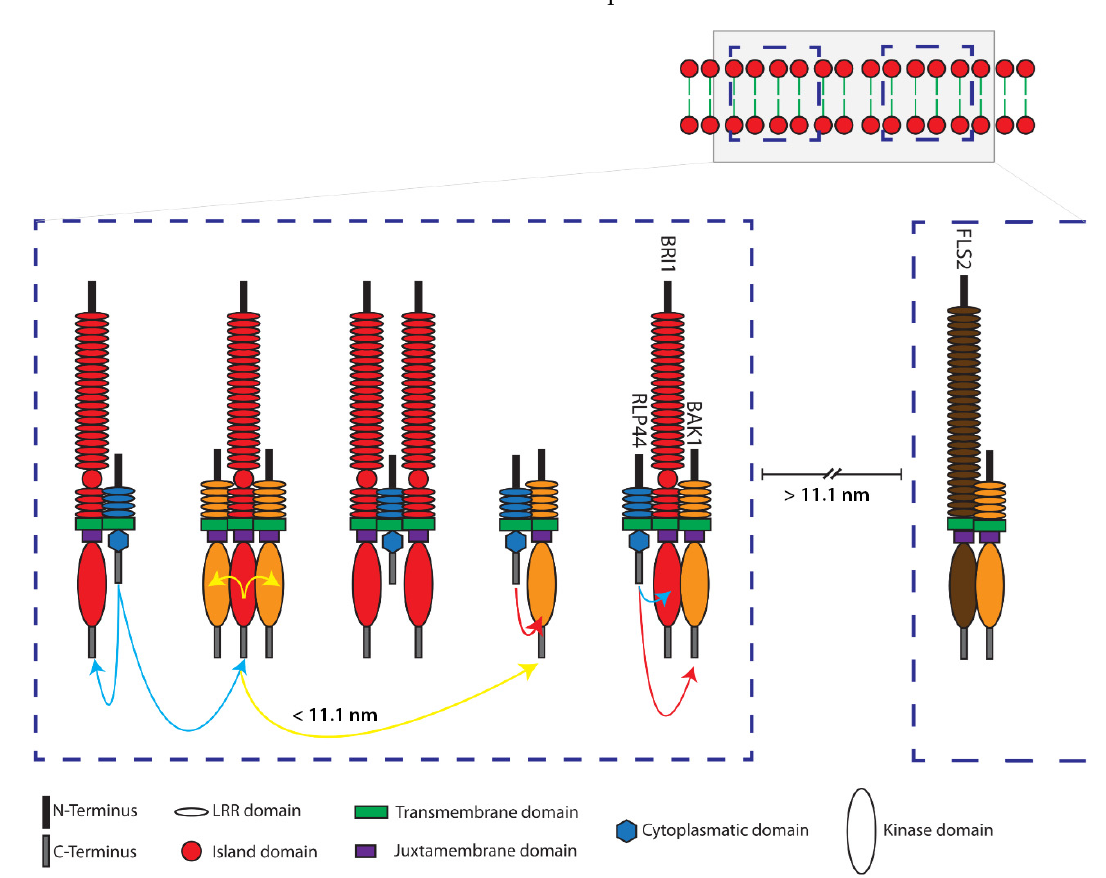
Figure 6. Model of the ternary interactions and spatial distances of RLP44, BRI1, BAK1 and FLS2 in defined nanodomains located in the plasma membrane of plant cells, as determined by three-fluorophore, intensity-based spectral FRET or FRET-FLIM. Shown are two distinct schematic nanodomains (blue dashed squares in the top corner) in the plasma membrane. The left nanodomain in the enlargement consists of RLP44-mTRQ2 (blue), BRI1-mVEN (red) and BAK1-RFP (orange)— without the fluorophores and not in scale. The formation of different complexes is demonstrated by FRET between mTRQ2 and mVEN by blue, mVEN and mRFP by yellow and mTRQ2 and mRFP by red arrows. FRET is also possible between the fusion proteins of differently composed complexes, if they are in a distance of ≤ 11.1 nm (representative yellow arrow). Due to the absence of FRET, for instance, the BAK1-mVEN/FLS2-mRFP (brown) complex must be at least 11.1 nm separated from the nanodomain, that contains the RLP44 related complexes, which is very likely part of an independent nanodomain (right side in the enlargement).